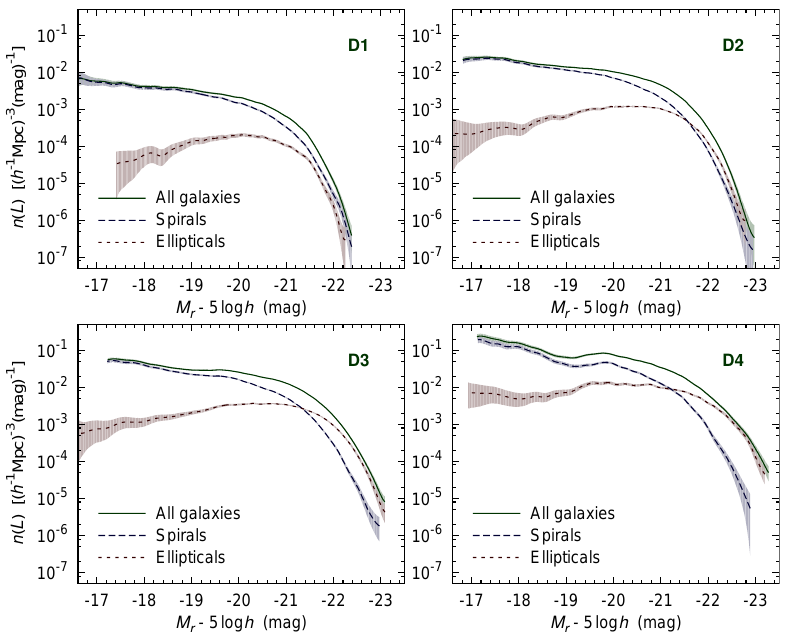
Fig. 3. Attenuation-corrected LFs for different types of galaxies in different environ- ments: the upper-left panel shows the LFs for least dense environment (D1) and the bottom-right panel shows the LFs for most dense environment (D4). Green solid lines show the LFs for all galaxies; blue dashed lines show the LFs for spiral galaxies; red dot- ted lines show the LFs for elliptical galaxies. The shaded areas show the 95% confidence regions. The LFs have been normalised to the volume of each sample.